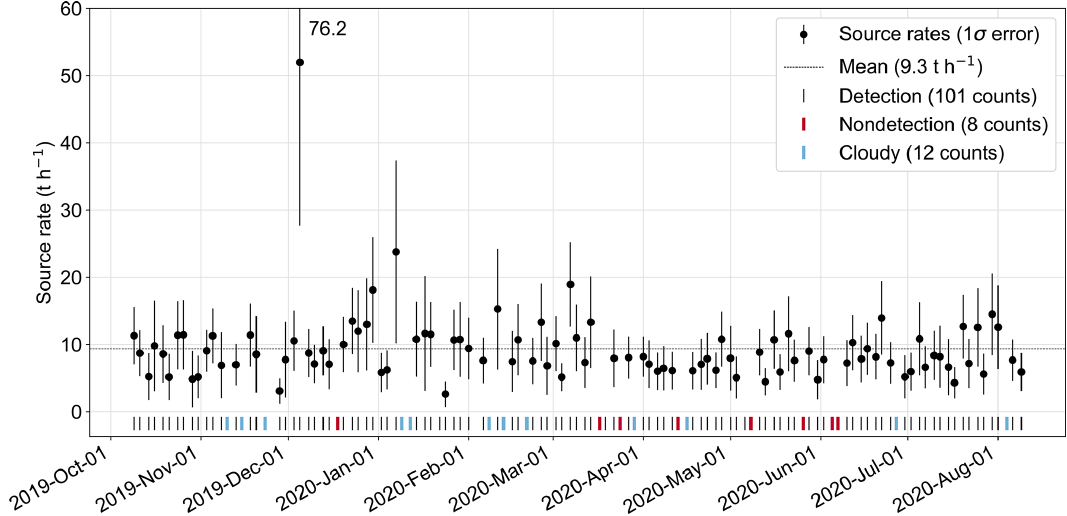
Figure 6. Time series of retrieved source rates for the Hassi Messaoud oil field point source using the MBMP retrieval and the IME